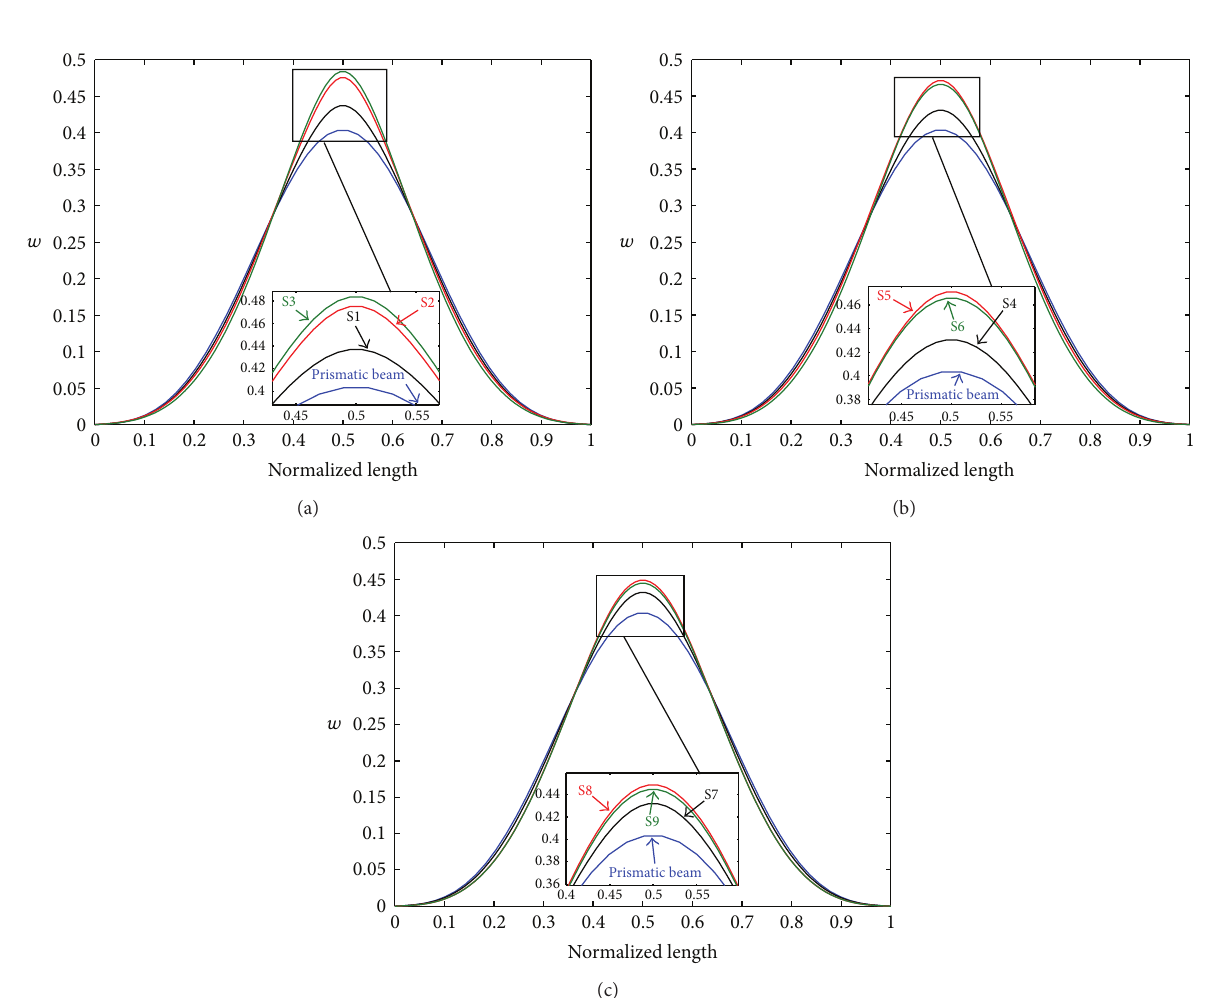
Figure 3: Deformation of the optimized microbeam: (a) S1–S3; (b) S4–S6; (c)